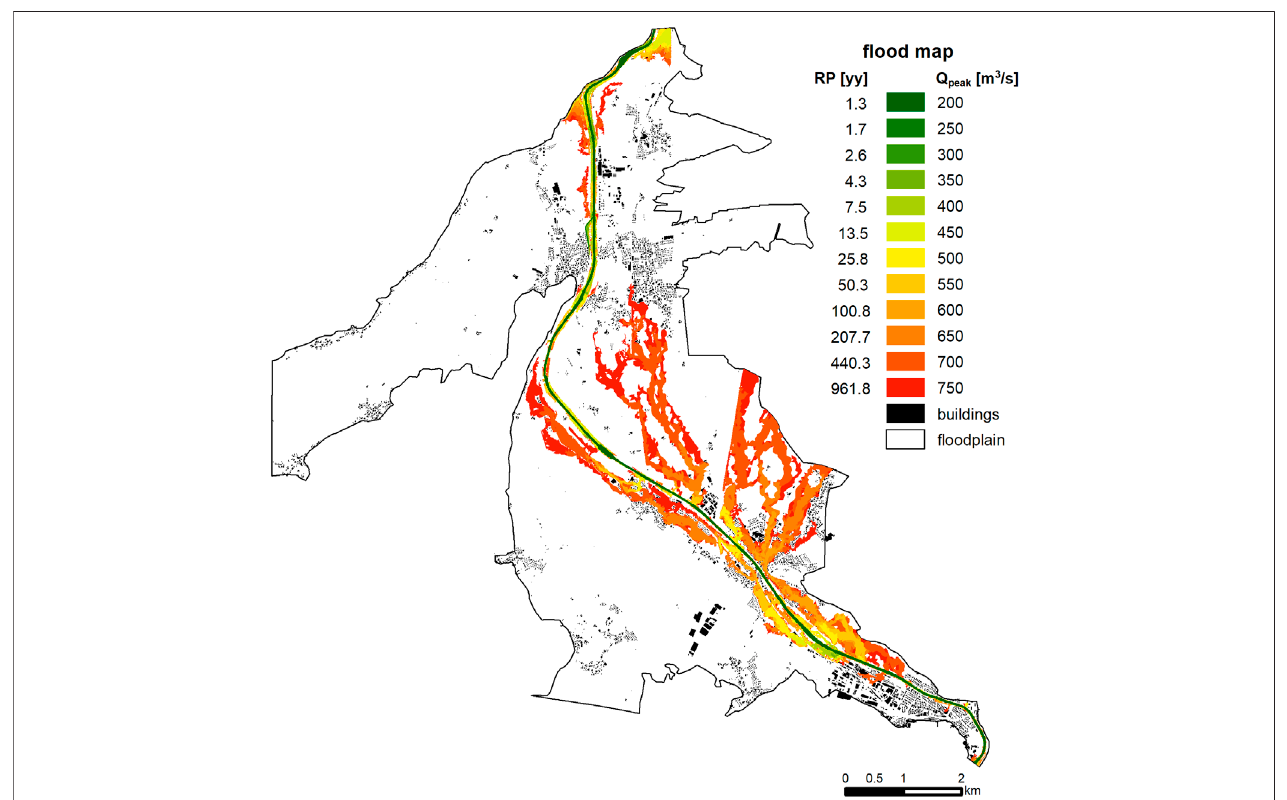
FIGURE 3 | Flood map of the Emme River fl oodplain downstream of Burgdorf, Canton ofBern, Switzerland. The colors show the peak discharge required to fl ood the spatial subunits and the corresponding return periods.